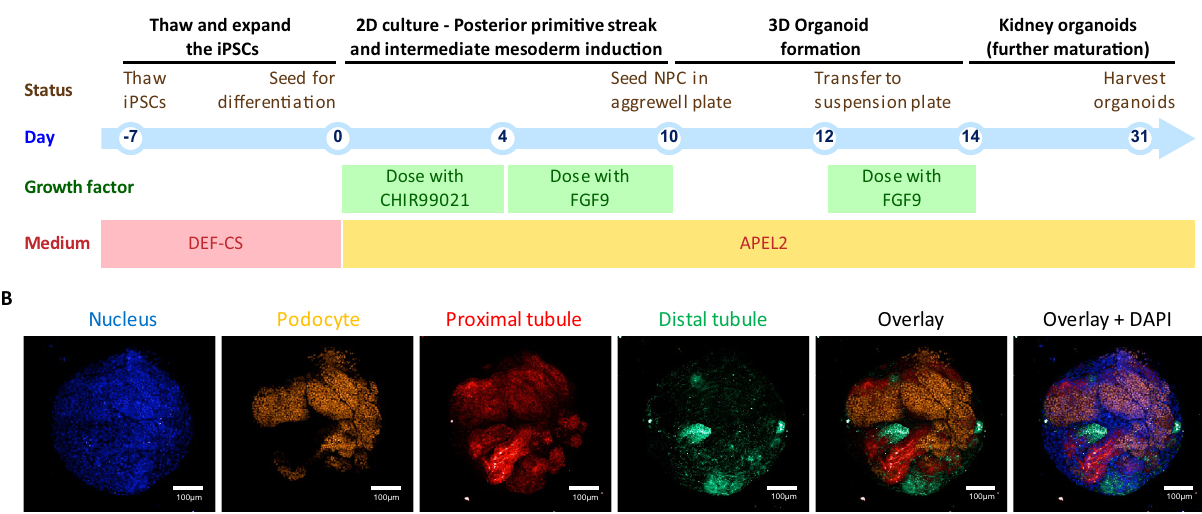
Figure 1. Differentiation of hiPSC into kidney organoids. ( A ) The schematic outline for the multi-stage kidney organoid differentiation is shown. ( B ) The resulting kidney organoids (day31) stained and imaged using confocal microscopy for DAPI and kidney specific markers including WT1, LTL and ECAD for podocyte, proximal tubule and distal tubule,